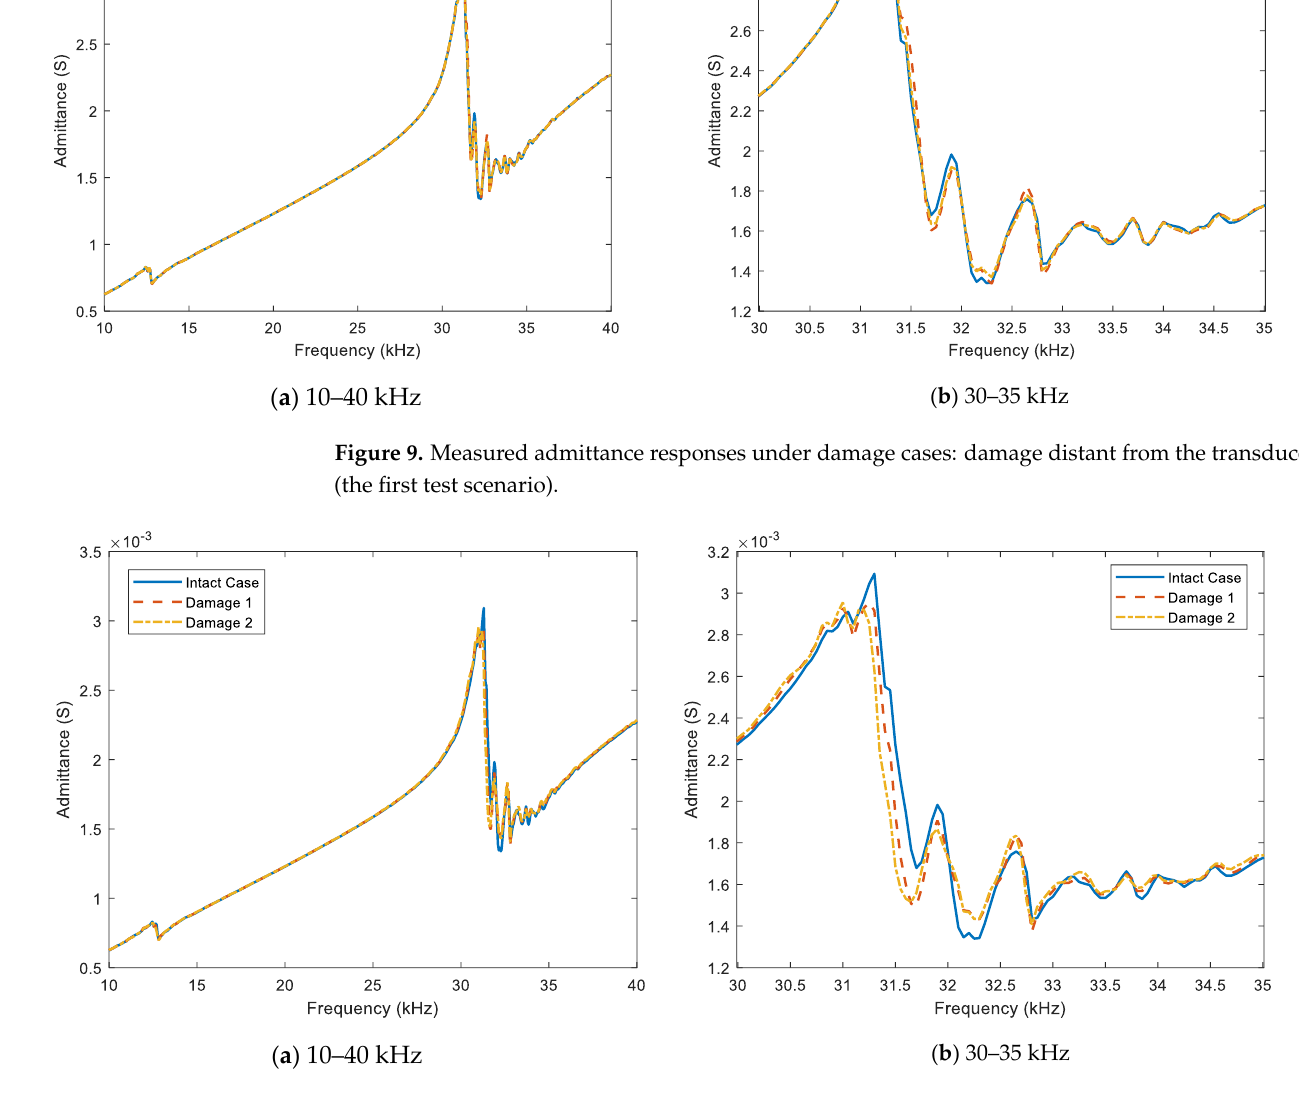
Figure 10. Measured admittance responses under damage cases: damage close to the transducer (the second test scenario).